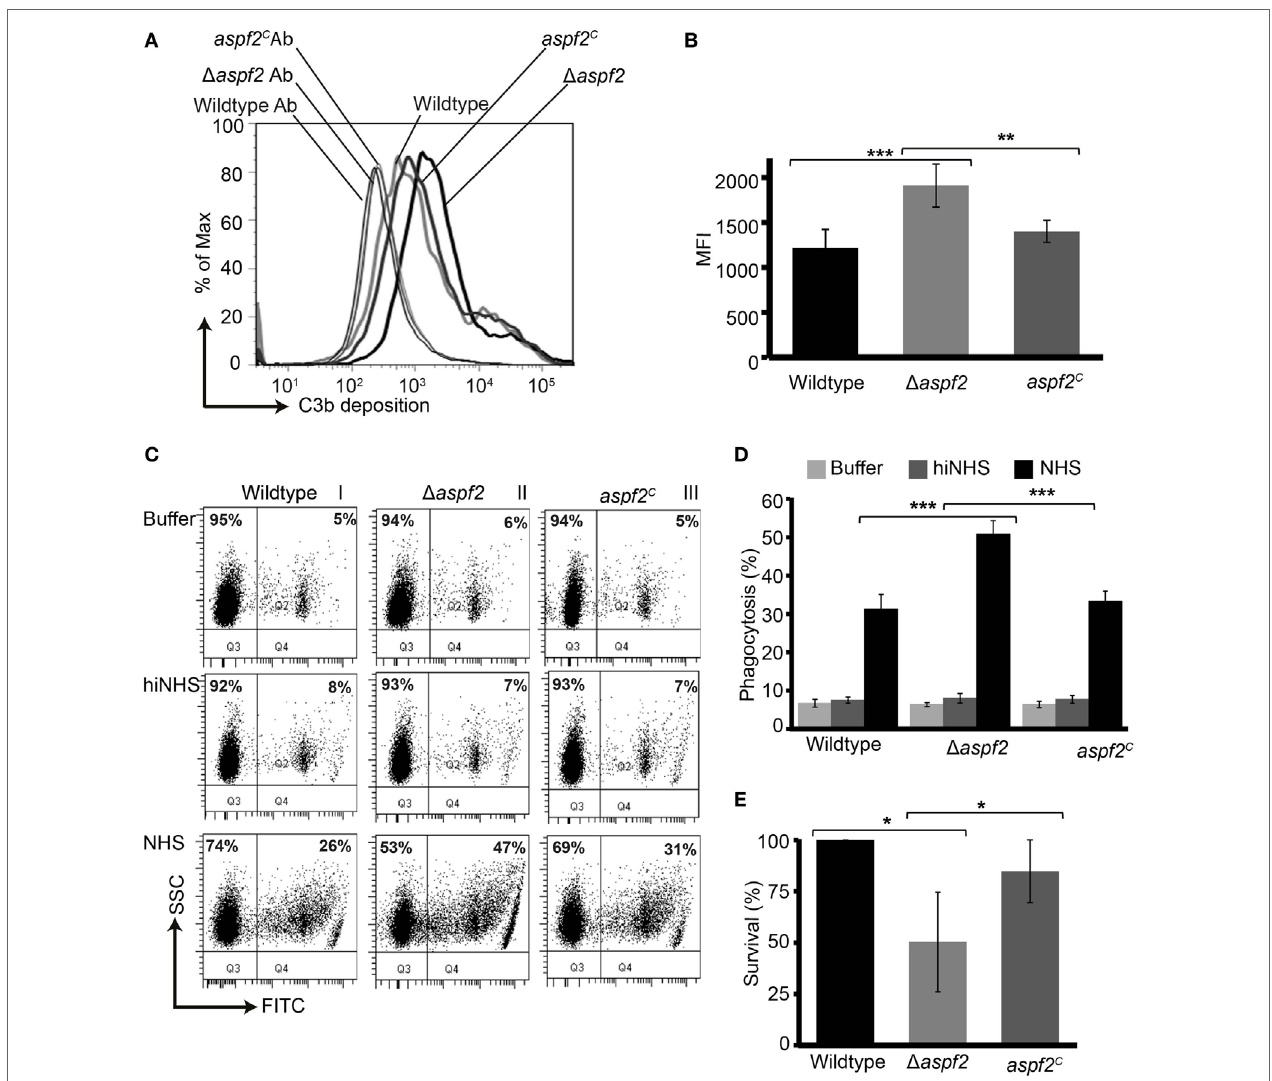
FigUre 5 | Δ aspf2 conidia are more efficiently opsonized and phagocytized and killed by human neutrophils. (a) Δ aspf2 , wild-type, and aspf2 C conidia were challenged with complement-active normal human serum (NHS) (20%, v/v) for 20 min. After washing, surface-deposited C3b was analyzed by flow cytometry. (B) Δ aspf2 conidia had more C3b on their surface (157%) as compared to wild-type conidia (100%) and aspf2 C (115%). (c) FITC-labeled wild-type, Δ aspf2, and aspf2 C conidia were incubated with human neutrophils at 5:1 in the Hanks balanced salt solution (HBSS) (upper panels), or complement inactive hiNHS (middle panels) or in complement-active NHS (20%, v/v) (lower panels) for 25 min. Human neutrophils having conidia phagocytized were identified based on granularity and FITC positivity by flow cytometry (panels I and II, quadrant Q2); neutrophils without conidia were identified as FITC negative cells (panels I and II, quadrant Q1). A representative experiment out of three independent assays is shown. (D) In the presence of complement-active human serum (NHS) Δ aspf2 , conidia were more efficiently phagocytosed (51%) compared to wild-type (31%) and aspf2 C (33%). However, in HBSS (upper panel) or in the absence of complement inactive serum (middle panel), phagocytosis was low and all strains were phagocytosed by the same intensity. Data from (e) Δ aspf2 conidia were efficiently killed by human neutrophils. Δ aspf2, wild-type, and Δ aspf2 c conidia were coincubated with human neutrophils for 5 h RPMI 1640 supplemented with 5% (v/v). After incubation, PMNs were lysed with sterile deionized ice-cold water. Samples were then diluted sequentially to a final dilution of 1:10,000 in PBS containing 0.5% (v/v) Tween 20 and plated (20 µl) on Sabouraud 2% (w/v) glucose-agar; colony forming units were counted. The survival of Δ aspf2 conidia was decreased to 56% compared to wild-type (100%) and aspf2 C conidia (89%). Panels (B,D,e) represent mean ± SD of three independent